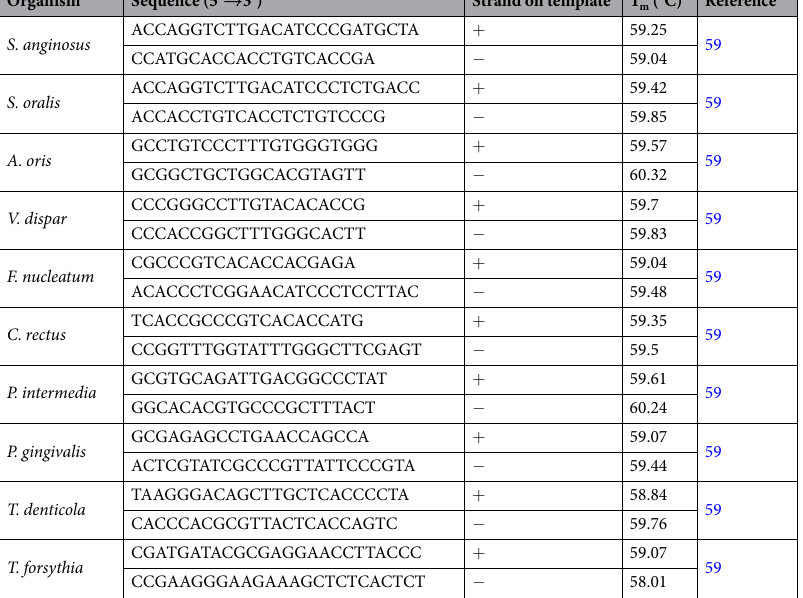
Table 2. Primer sequences and properties. T m , melting